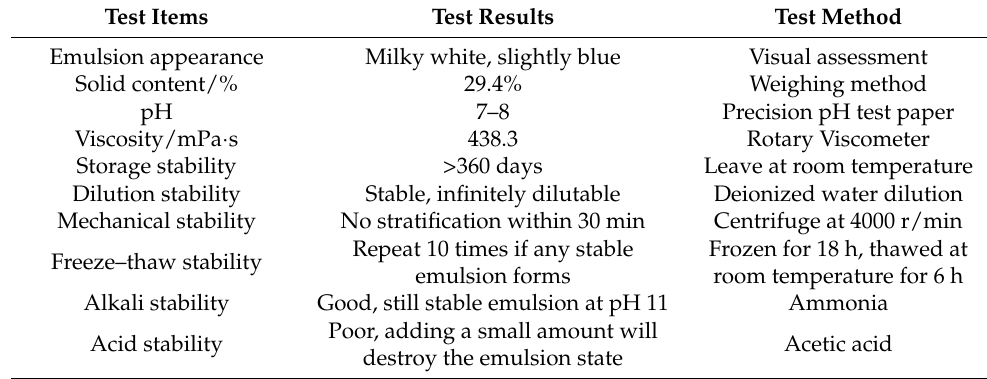
Table 10. Emulsion performance